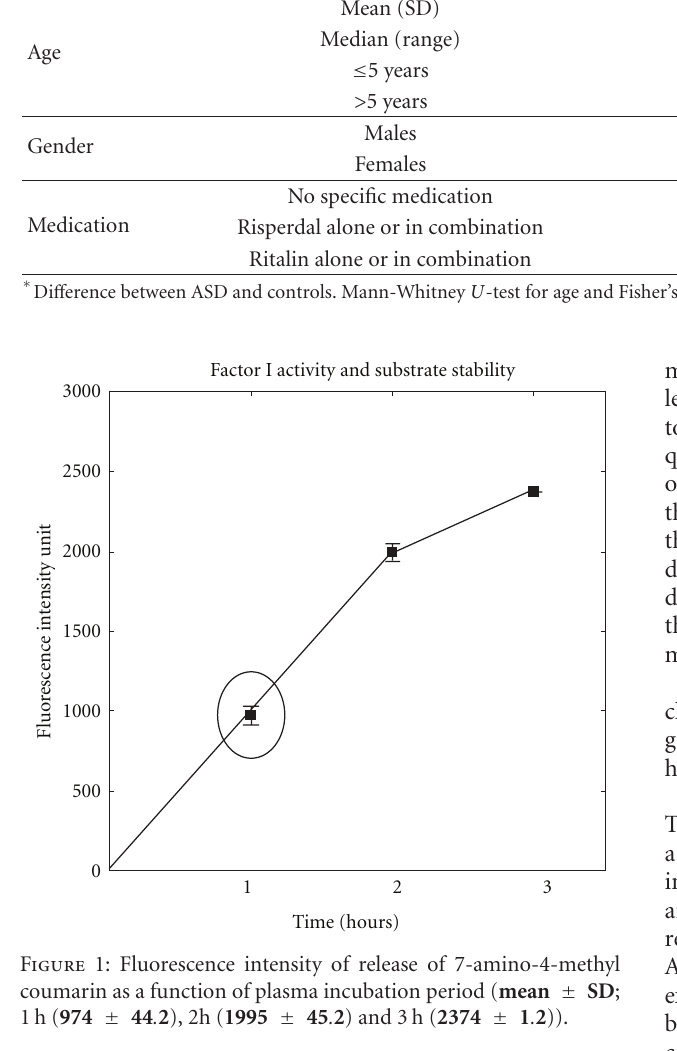
Table 1: Age/y, gender, and medication of the participants.